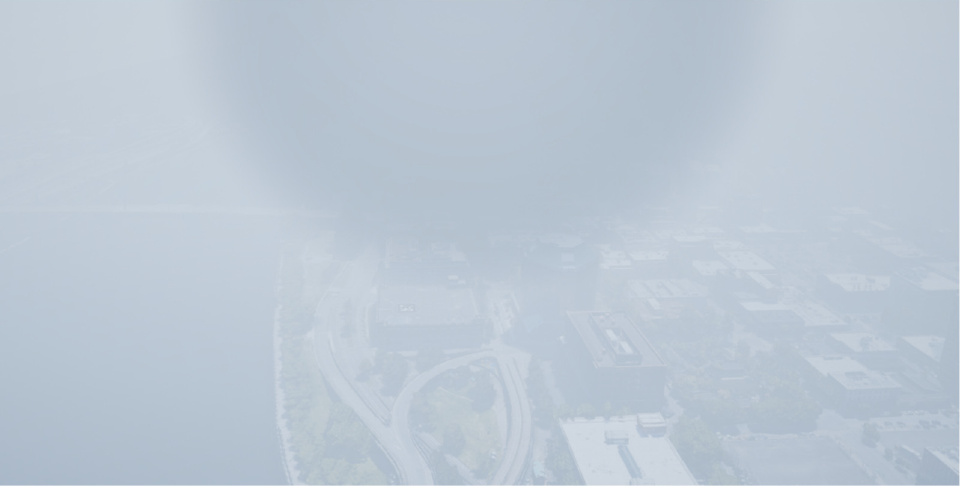
Figure 21. UE4 reproduction of Portland heliport and its surroundings with local fog banks.